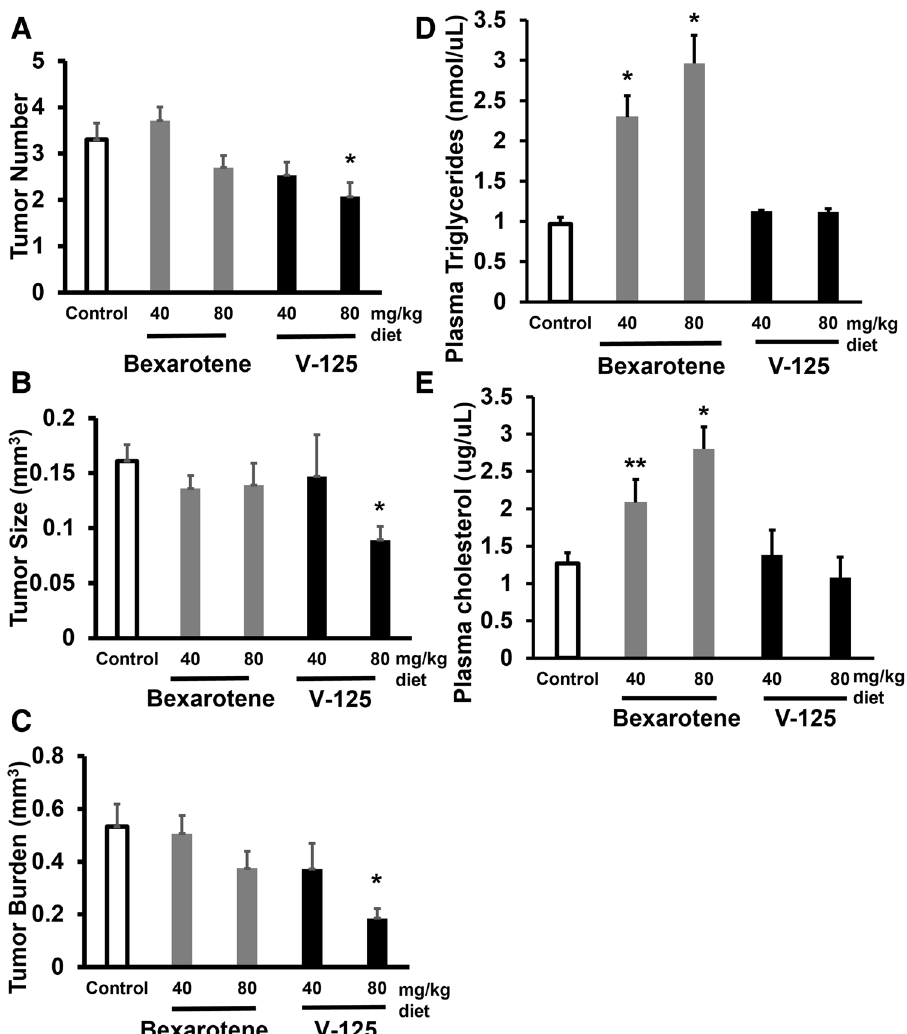
Figure 2. V-125 reduces lung tumor burden in A/J mice. Female A/J mice were injected with vinyl carbamate and starting 2 weeks later, fed control diet or V-125 in diet for 16 weeks. At the end of the study, mice were euthanized and lungs sectioned for analysis. Average tumor number ( A ), tumor size ( B ), and tumor burden ( C ) in control vs. drug treated groups. Results shown as means ± SE (*P < 0.05 vs. control). Control, bexarotene 40 and 80 mg/kg, and V-125 40 mg/kg: N = 15 mice per group. V-125 80 mg/kg: N = 14 mice per group. Plasma triglycerides ( D ) and cholesterol ( E ) were measured with commercial kits (*P < 0.01 vs. control; **P < 0.001 vs. control; n = 6 samples/group). Error bars represent standard